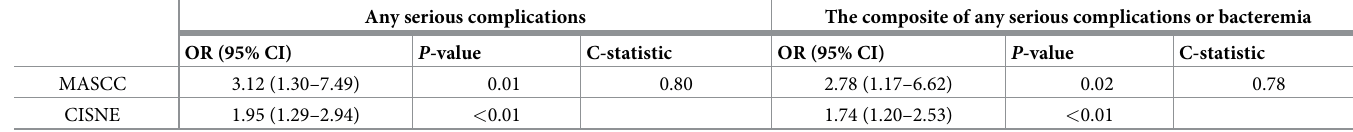
Table 3. Logistic regression analysis to predict any serious complications and composite of bacteremia or any serious